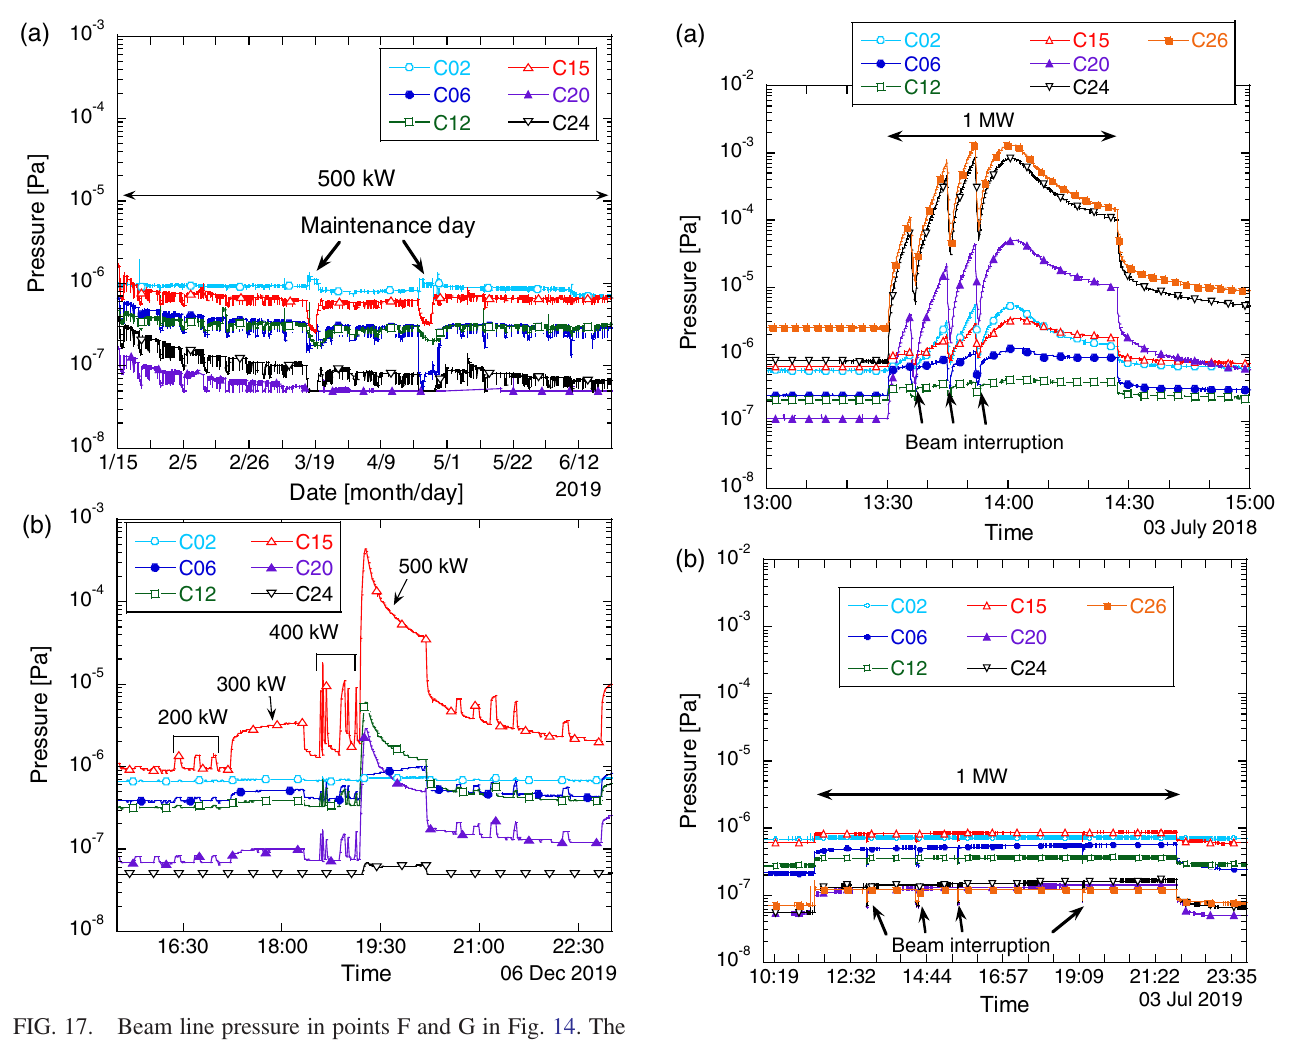
FIG. 18. Dynamic pressure during the 1 MW beam power operation in points X and XX in Fig. 14. The pressure measured by the same CCGs as Fig. 15 and the CCG in C26 is plotted.